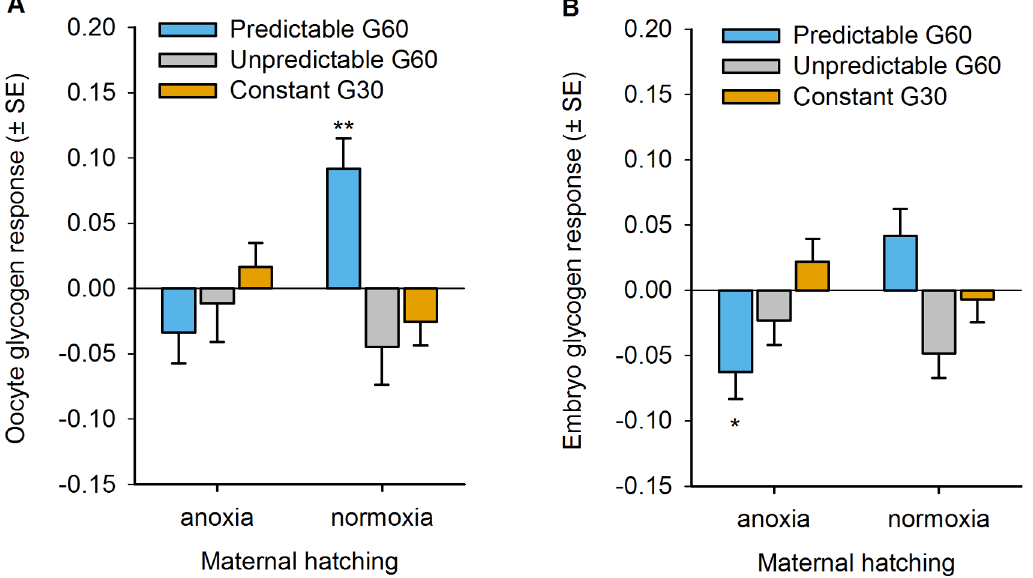
Fig 6. Evolution of maternal glycogen provisioning. Glycogen content is quantified in iodine-stained hermaphrodites at the time of reproduction during experimental evolution. Oocyte (A) and in utero embryo (B) glycogen content of the predictable (blue) and unpredictable (grey) populations at generation 60, or constant populations at generation 30 (orange), relative to the ancestral population (zero line). See S5 and S6 Figs and Materials and Methods for assay details and controls. Mean and error least square estimates are shown after separate LMM for each experimental regime, taking replicate population and individual hermaphrodite as random factors and maternal treatment as a fixed factor. Significant evolutionary responses (Student t tests, with LMM-corrected KR degrees of freedom) are shown above each bar: * p < 0.05; ** p < 0.01. Data deposited in the Dryad repository: http://dx.doi.org/10.5061/dryad.56bb4